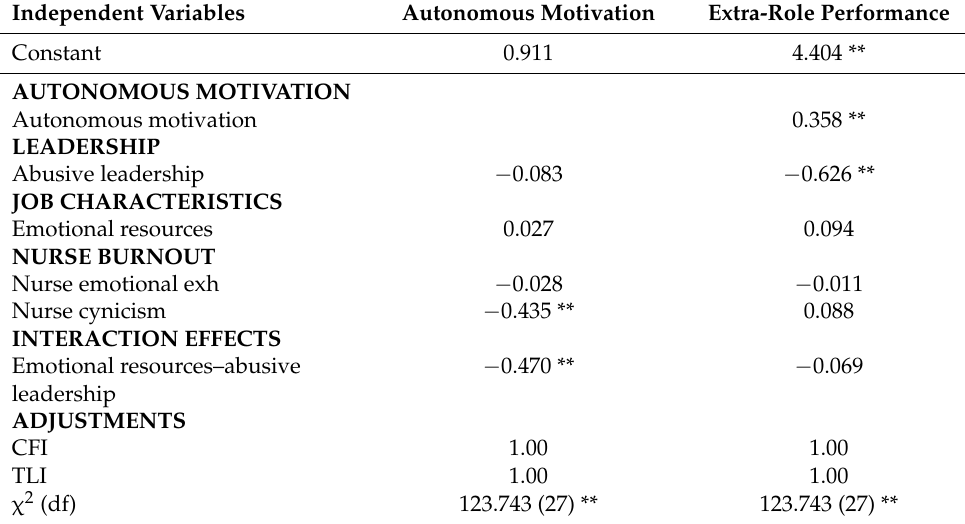
Table 2. Main effects on autonomous motivation and objective job